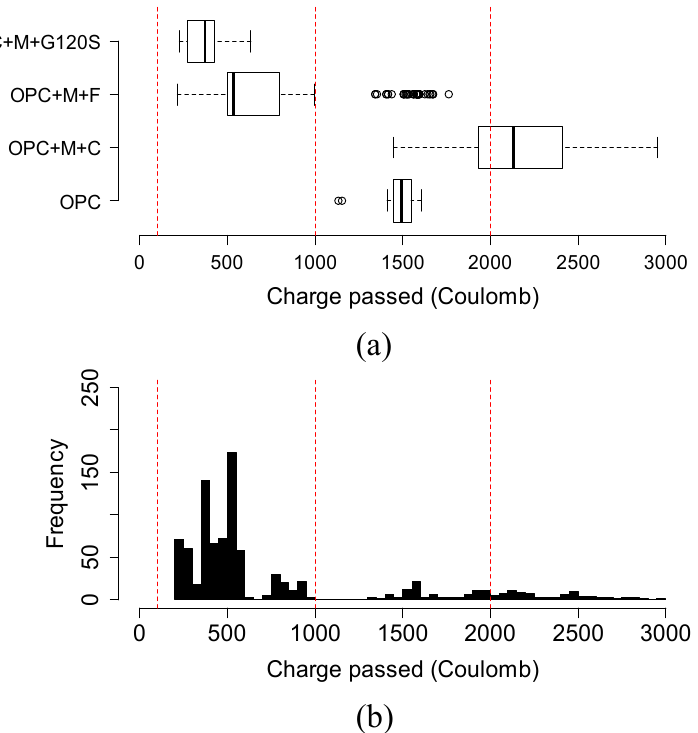
Figure 12. ( a ) Variation and ( b ) distribution of charge passed of metakaolin-based mixtures at 91 days. Three vertical red lines in the box plot represent the range of negligible, very low, and low permeability chloride ion permeability class as classified by ASTM C1202 specification.